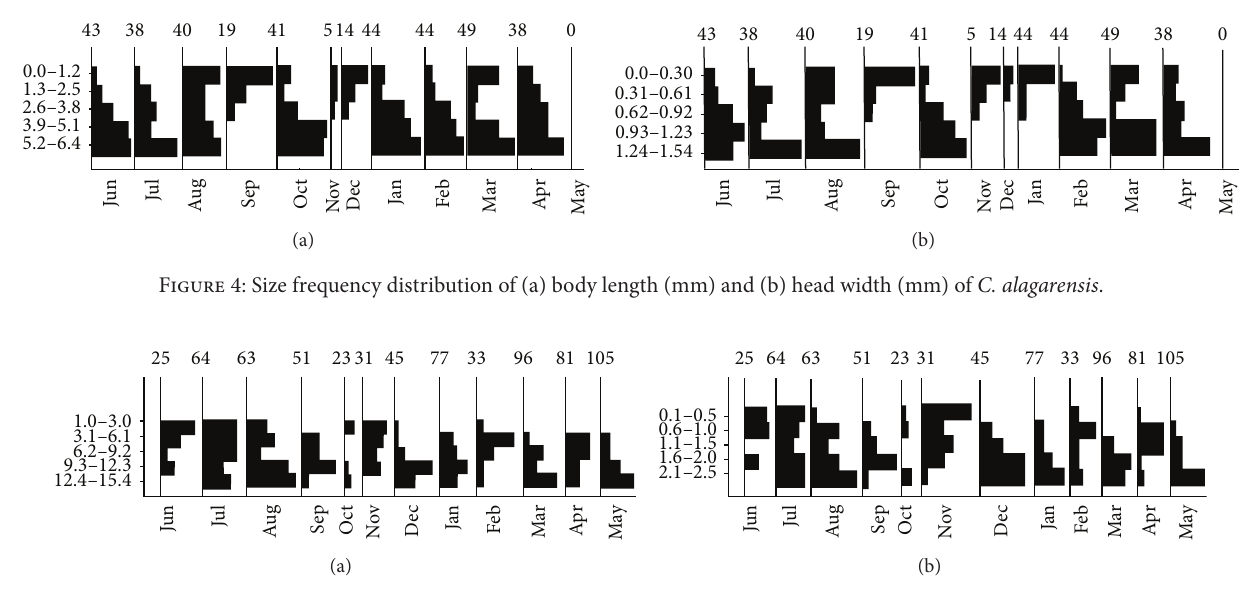
nine cohort productions in Baetis sp. and C. alagarensis